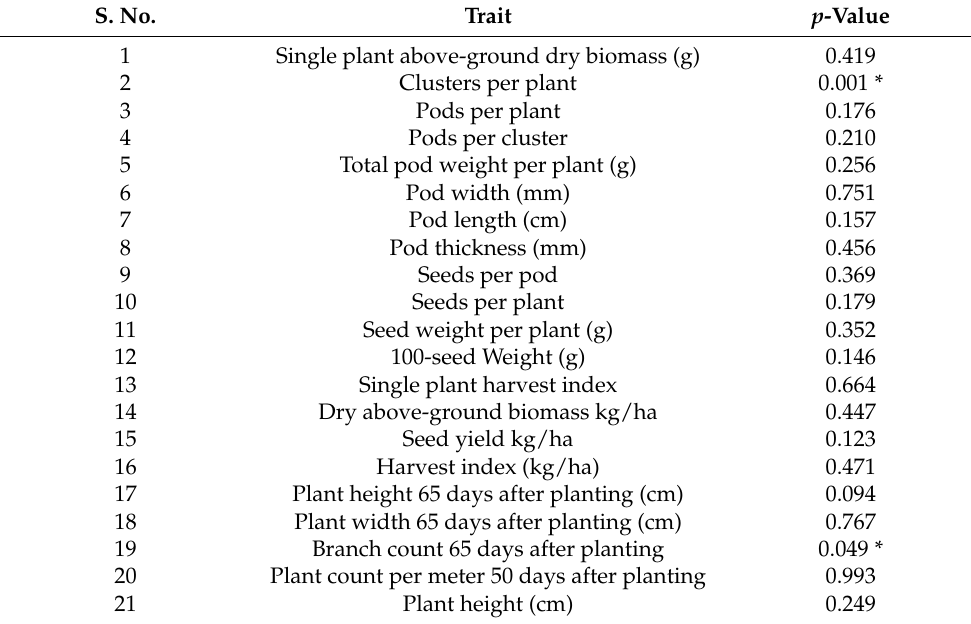
Table 2. Statistical analyses of different traits studied for four guar varieties. S. No.